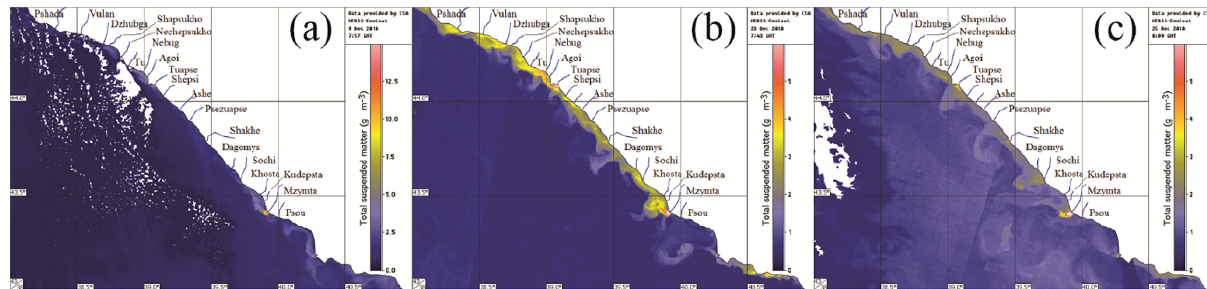
Figure 3. Satellite-derived surface TSM distribution at RCBS (a) before, (b) during, and (c) after a flash-flooding event.